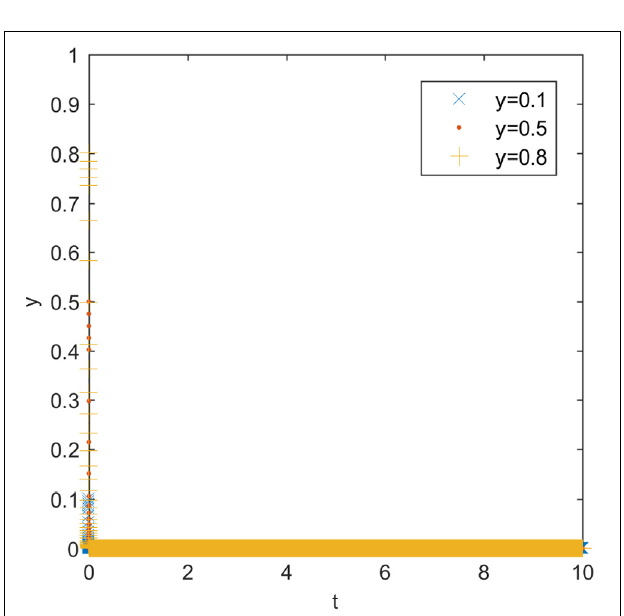
FIGURE 3 | G e − E < P relationships between enforcement level and financial penalties.